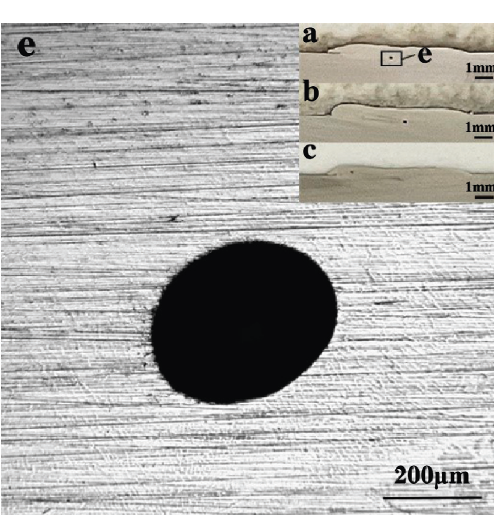
Figure 14: Cross-sectional morphology and partial enlargement of the cladding